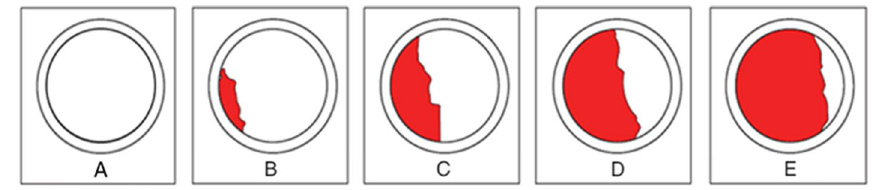
Figure 12. Dye penetration coverage percentage.